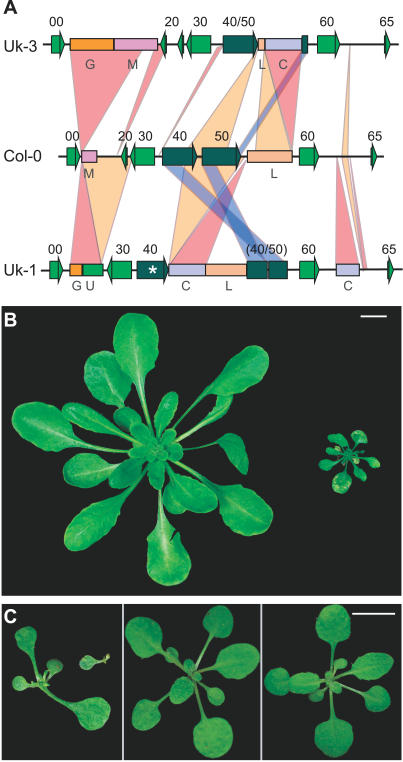
Identification of DM1 as an AT5G41740/AT5G41750 Allele(A) Schematic alignment of mapping interval. Genes are indicated with green boxes. Insertions relative to Col-0 are indicated with red triangles, deletions in beige, and duplications in blue. The last two digits of AT5G417XX gene identifiers are given above each line. AT5G41740 and AT5G41750 are NB-LRR genes. Uk-3 has only a single AT5G41740/AT5G41750 gene that is divergent from both Col-0 genes. Parentheses for Uk-1 indicate that these open reading frames are incomplete; asterisk indicates stop codon. Transposons are labeled below each line: MULE (M), copia (C), LINE (L), gypsy (G), and gypsy-associated UlpI protease sequence (U).(B) Uk-1/Uk-3 F1 hybrids grown at 16 °C, with transgenic sibling constitutively expressing amiRNA targeting AT5G41740/AT5G41750 on the left.(C) T1 plants carrying a Uk-3 genomic fragment that includes the AT5G41740/AT5G41750 allele. From left to right: Uk-1, Col-0, and Uk-3.Scale bars in (B) and (C) represent 1 cm.